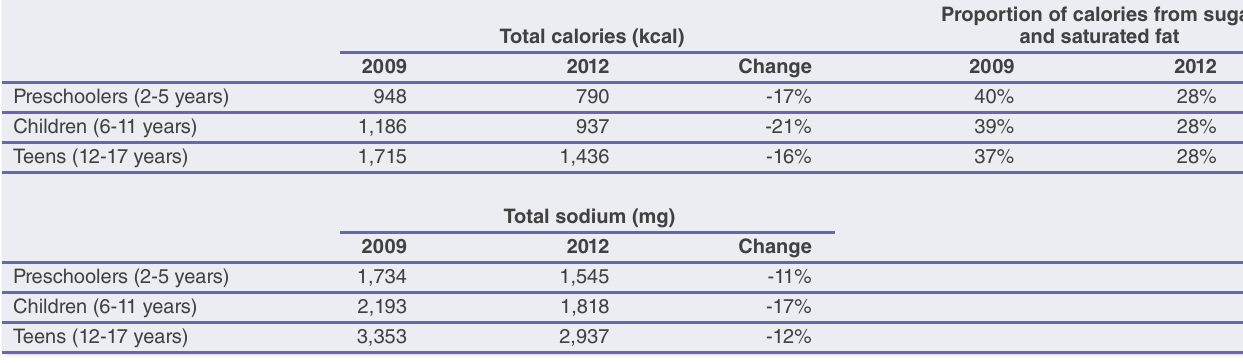
Table 23. Total nutrient content of items in TV ads viewed by youth every day